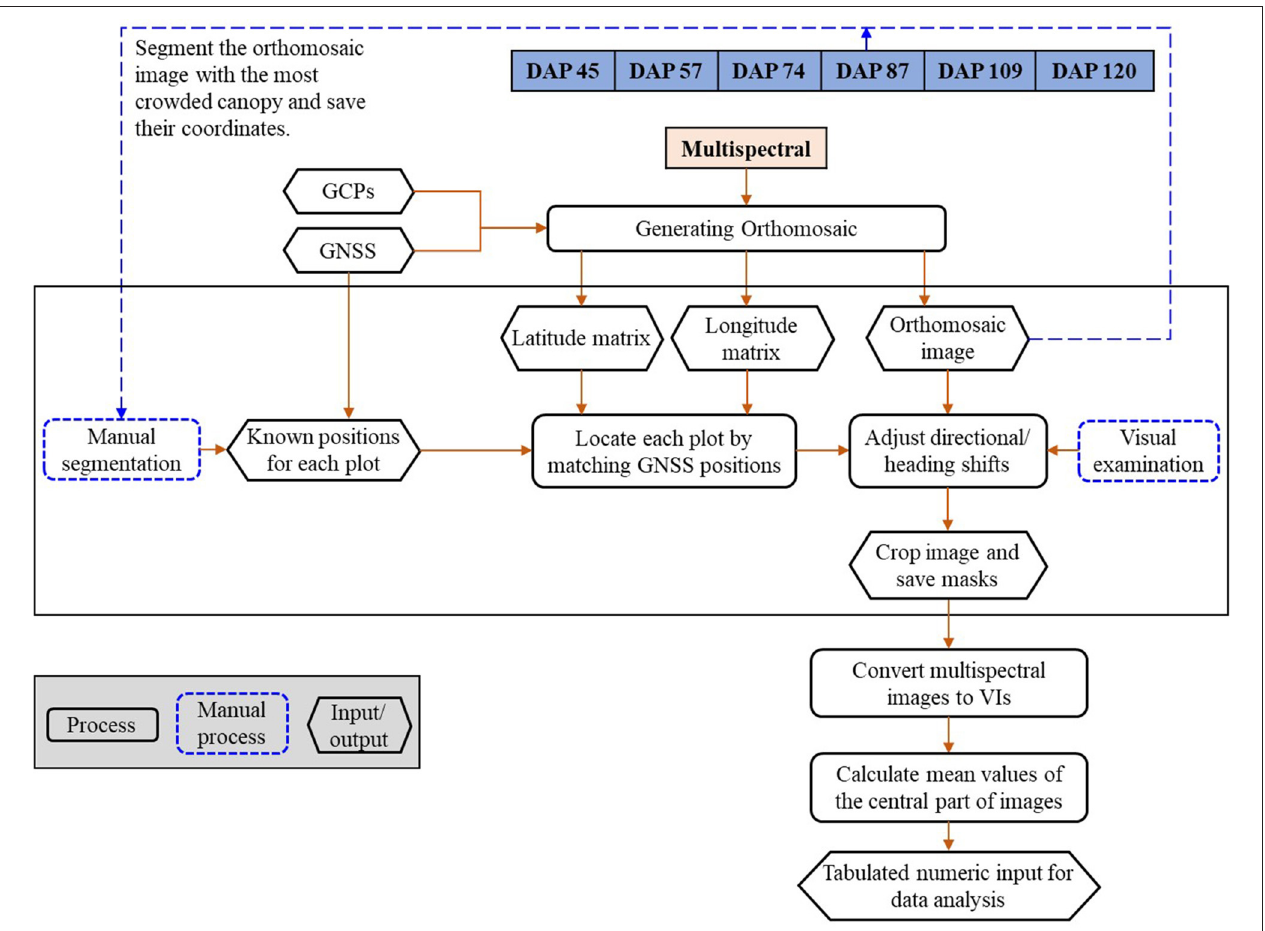
FIGURE 2 | The image processing